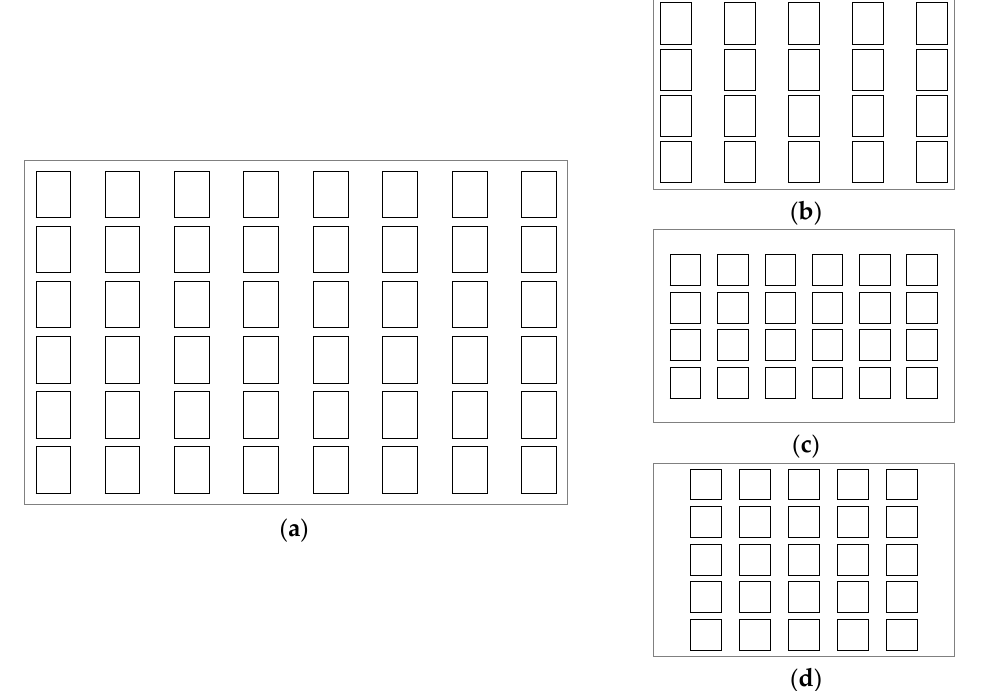
Figure 9. Typification for a regularly distributed façade at two different scales: ( a ) original distribution; ( b ) for scale reduced by 2×; ( c ) manual typification; ( d ) manual typification.